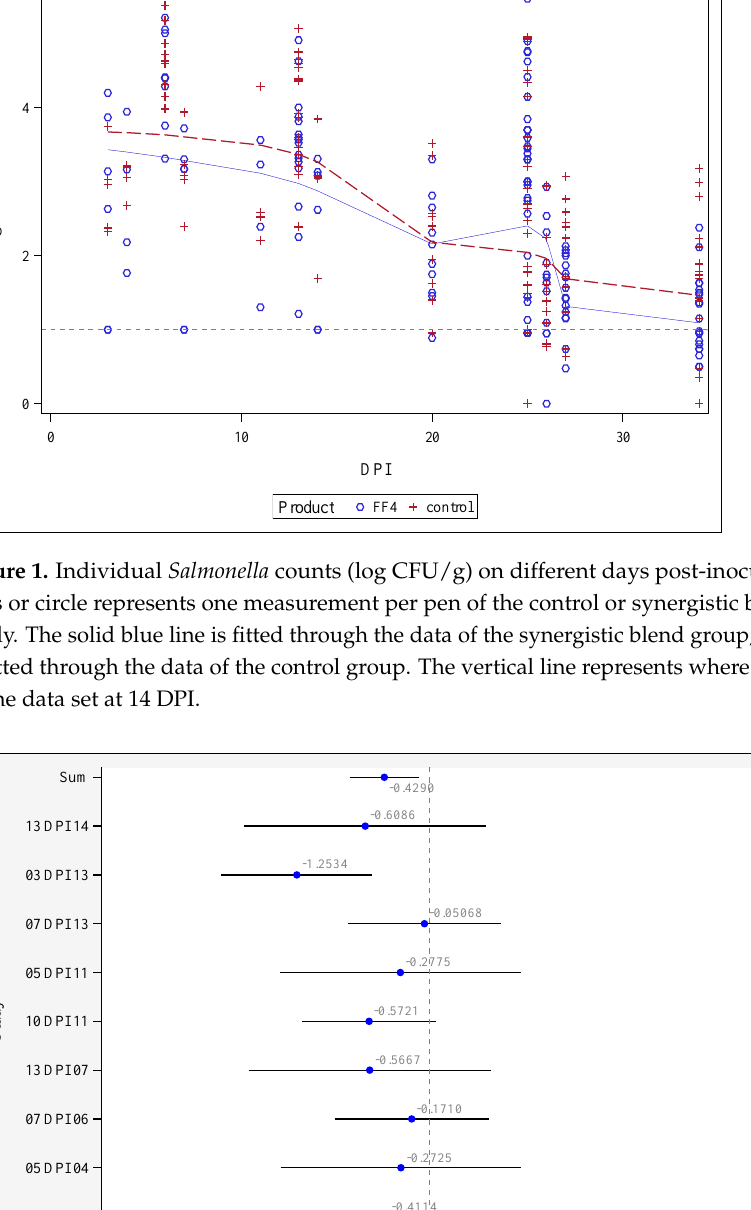
Figure 2. Forest plot showing the difference of the mean between control and synergistic blend (Treatment) for each study, and all studies combined (sum; p = 0.011), 0–14 days post-inoculation (DPI). The circles represent the log CFU/g difference between treatments, the bars represent the 95% confidence limits and the vertical line at 0 represents the value of no difference between treatments. Legend: XX DPI YY with XX = study number (see Table 1) and YY = days post-inoculation. Eight studies were included in the analysis of cecal Salmonella counts for 15–34 DPI.